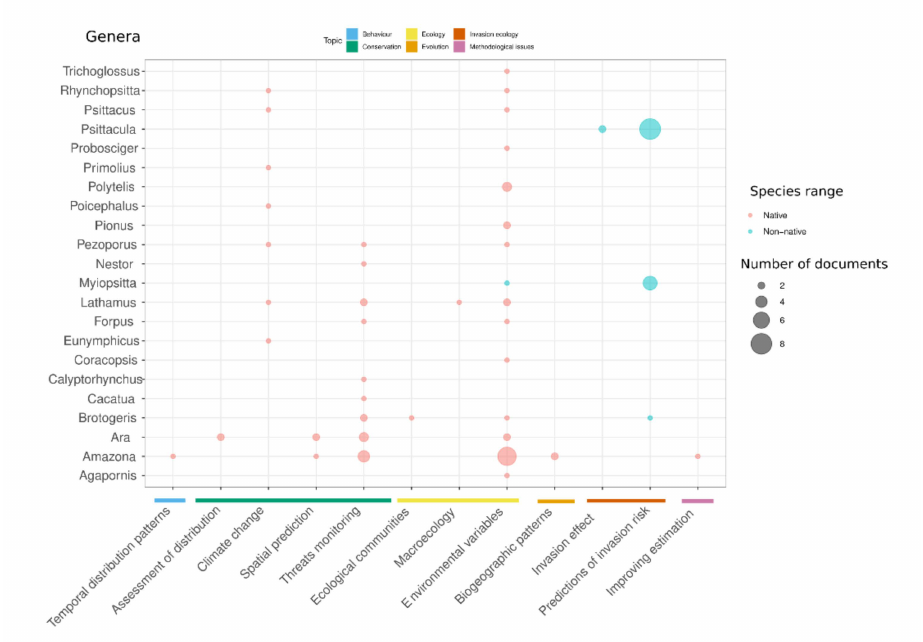
Figure 4. Taxonomic patterns of the published literature in parrots’ distribution modelling. The number of species by genus and application are shown. The circle size is proportional to the number of documents. Genera are in alphabetical order from bottom to top. Applications are grouped according to the main